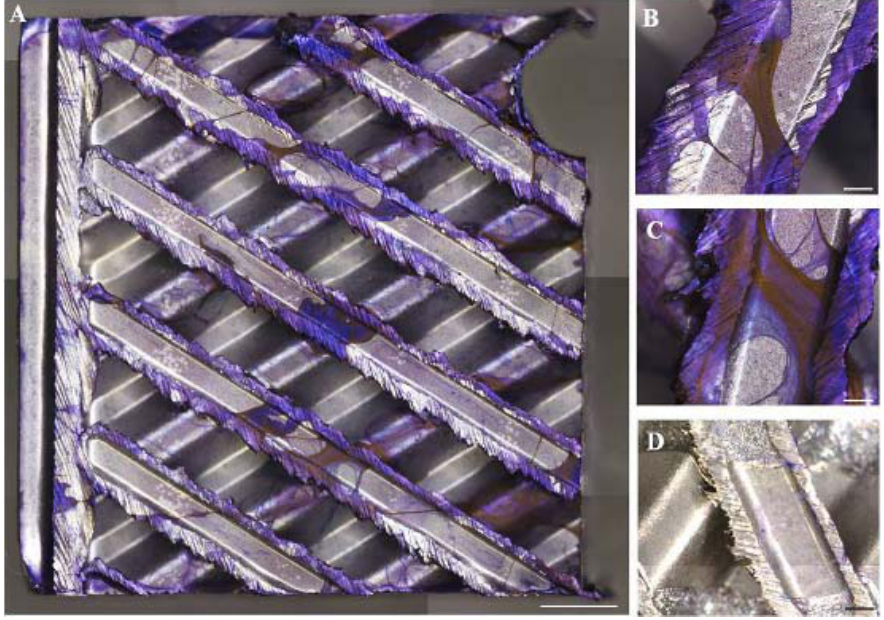
Figure 1. Crystal violet staining (purple) ( A ): mosaic images acquired by the motorized stereo